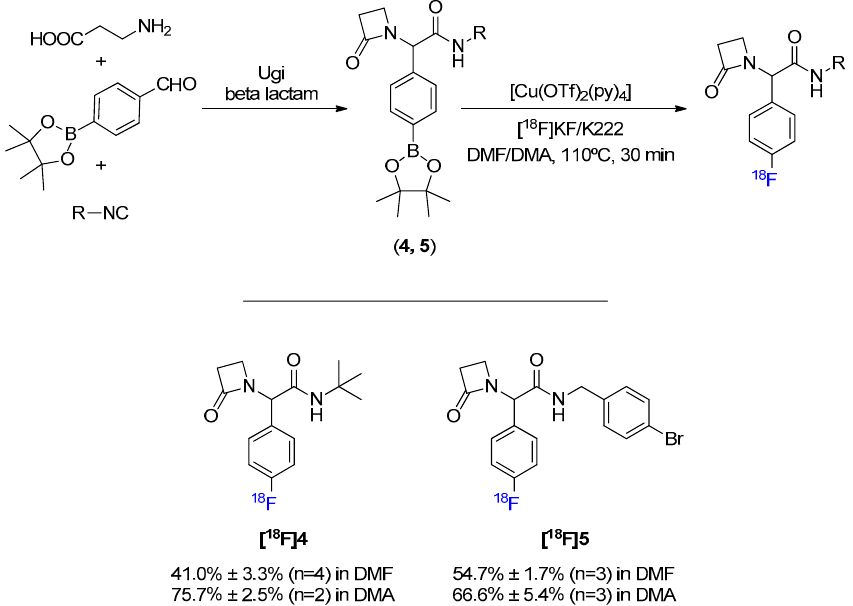
Scheme 3. General MCR synthesis and 18 F-fluorination of β -lactam scaffold.